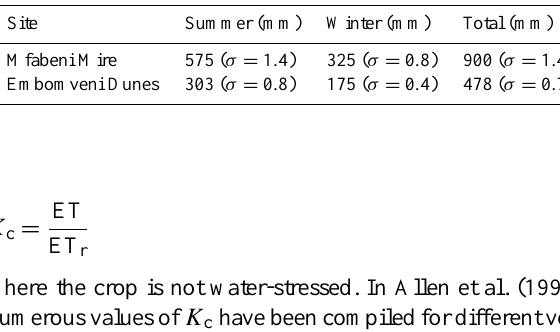
Table 2. Summary of seasonal and annual total evaporation derived using a surface renewal system to calculate the sensible heat flux.